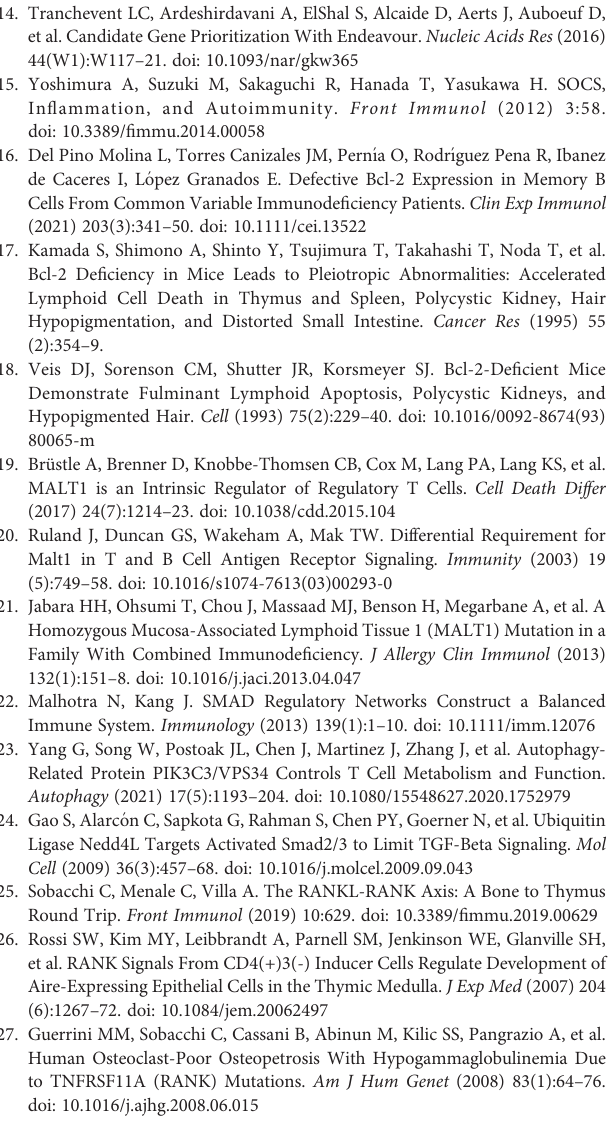
losses (x1) of genetic material of the 27 studied